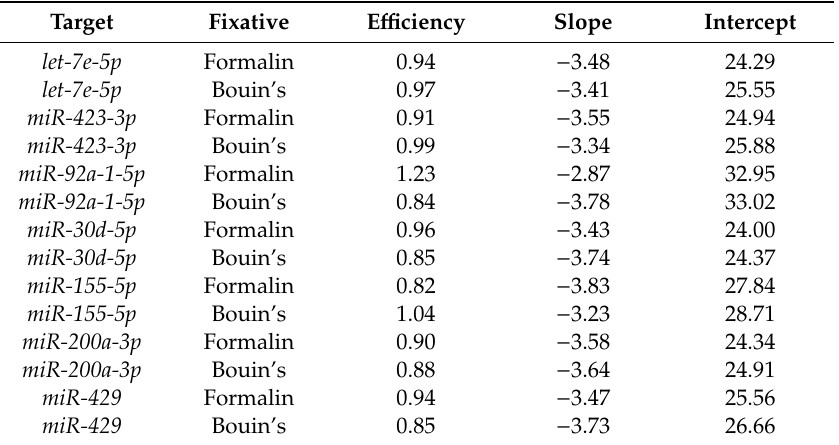
Table 1. Results of standardization curves of the analyzed